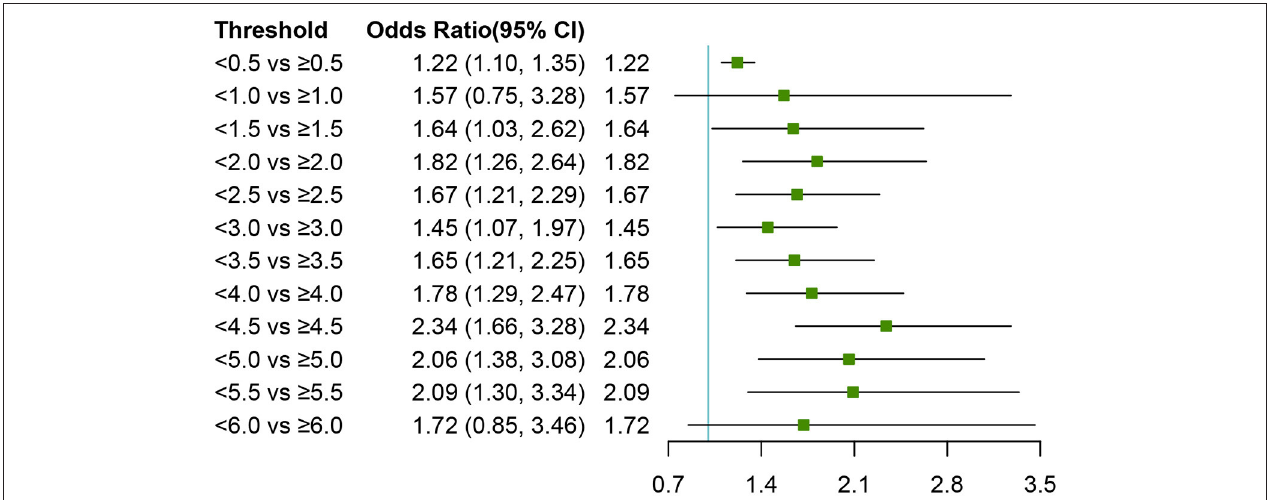
FIGURE 3 | Wide-ranged neutrophil-to-lymphocyte ratio thresholds and adjusted odds ratios of 90-day transplant-free mortality. The cohort of patients (NLR < 6.5) whose NLR was dichotomized into “low” vs. “not low” groups using various cut points in increments of 0.5. Logistic regression was used to estimate the odds ratio of death between the two groups, adjusting for age; gender; etiology (HBV, alcohol, autoimmune); cirrhosis; hepatic encephalopathy grades, infection, ascites, gastrointestinal bleeding; total bilirubin; international normalized ratio; serum creatinine. Squares indicate estimated adjusted odds ratios, and error bars indicate 95% CIs. NLR, neutrophil-to-lymphocyte ratio; OR, Odds Ratios.